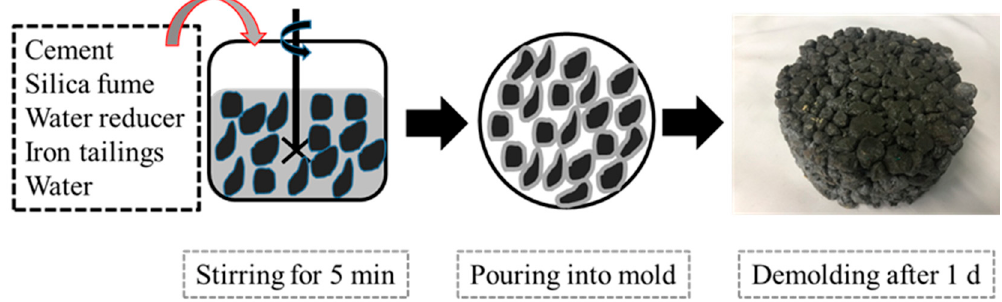
Figure 1. Preparation processes for pervious concrete.